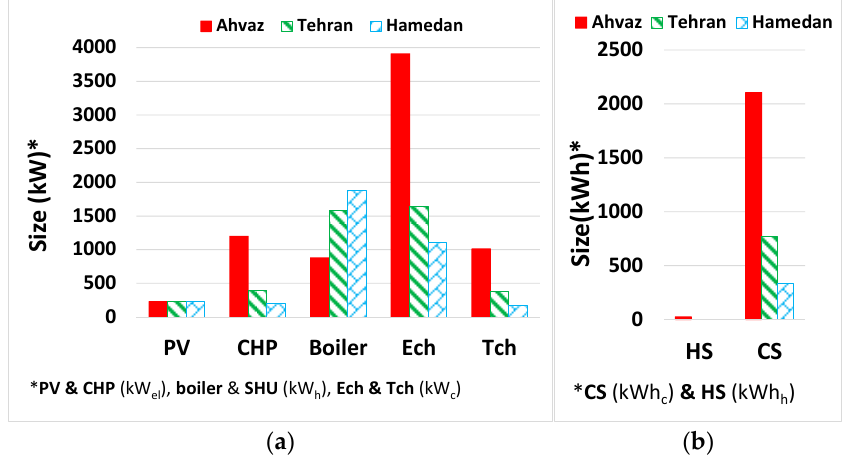
Figure 7. ( a ) Size of the components; photovoltaic (PV) (solar panels), CHP (combined heat and power), Ech (electric chiller) and Tch (thermal chiller); ( b ) HS (heat storage), CS (cold storage).